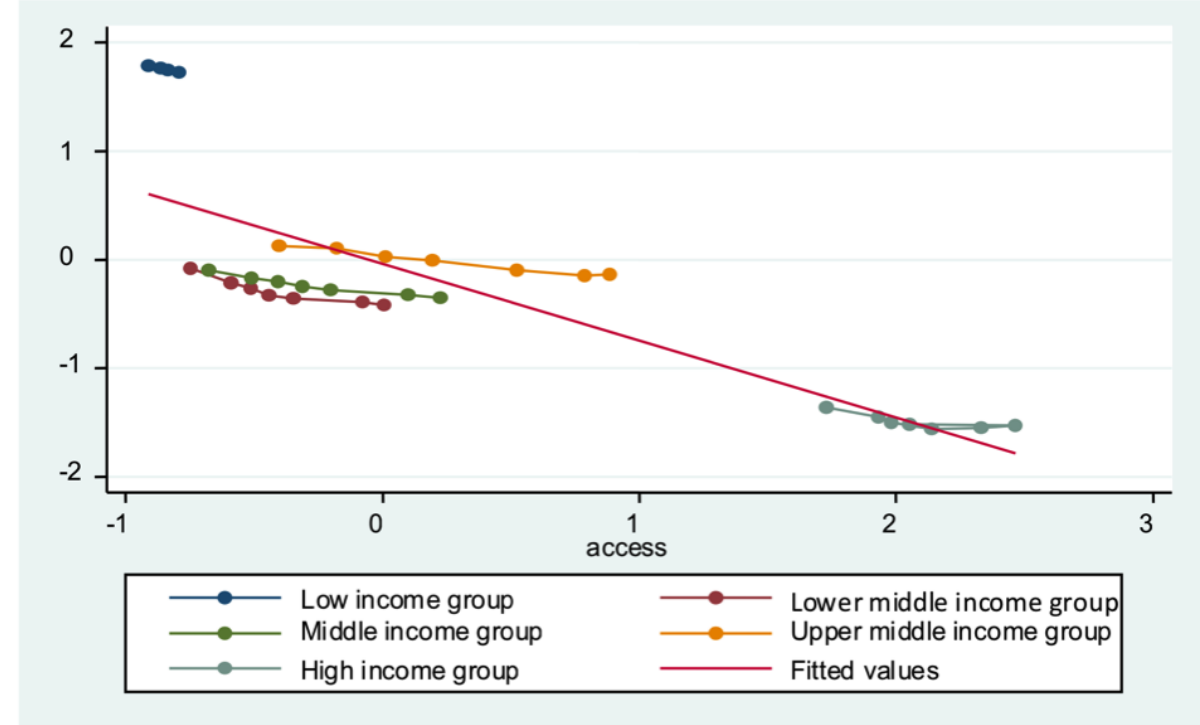
Figure 3. Impact of ICT accessibility on adolescent fertility rate.